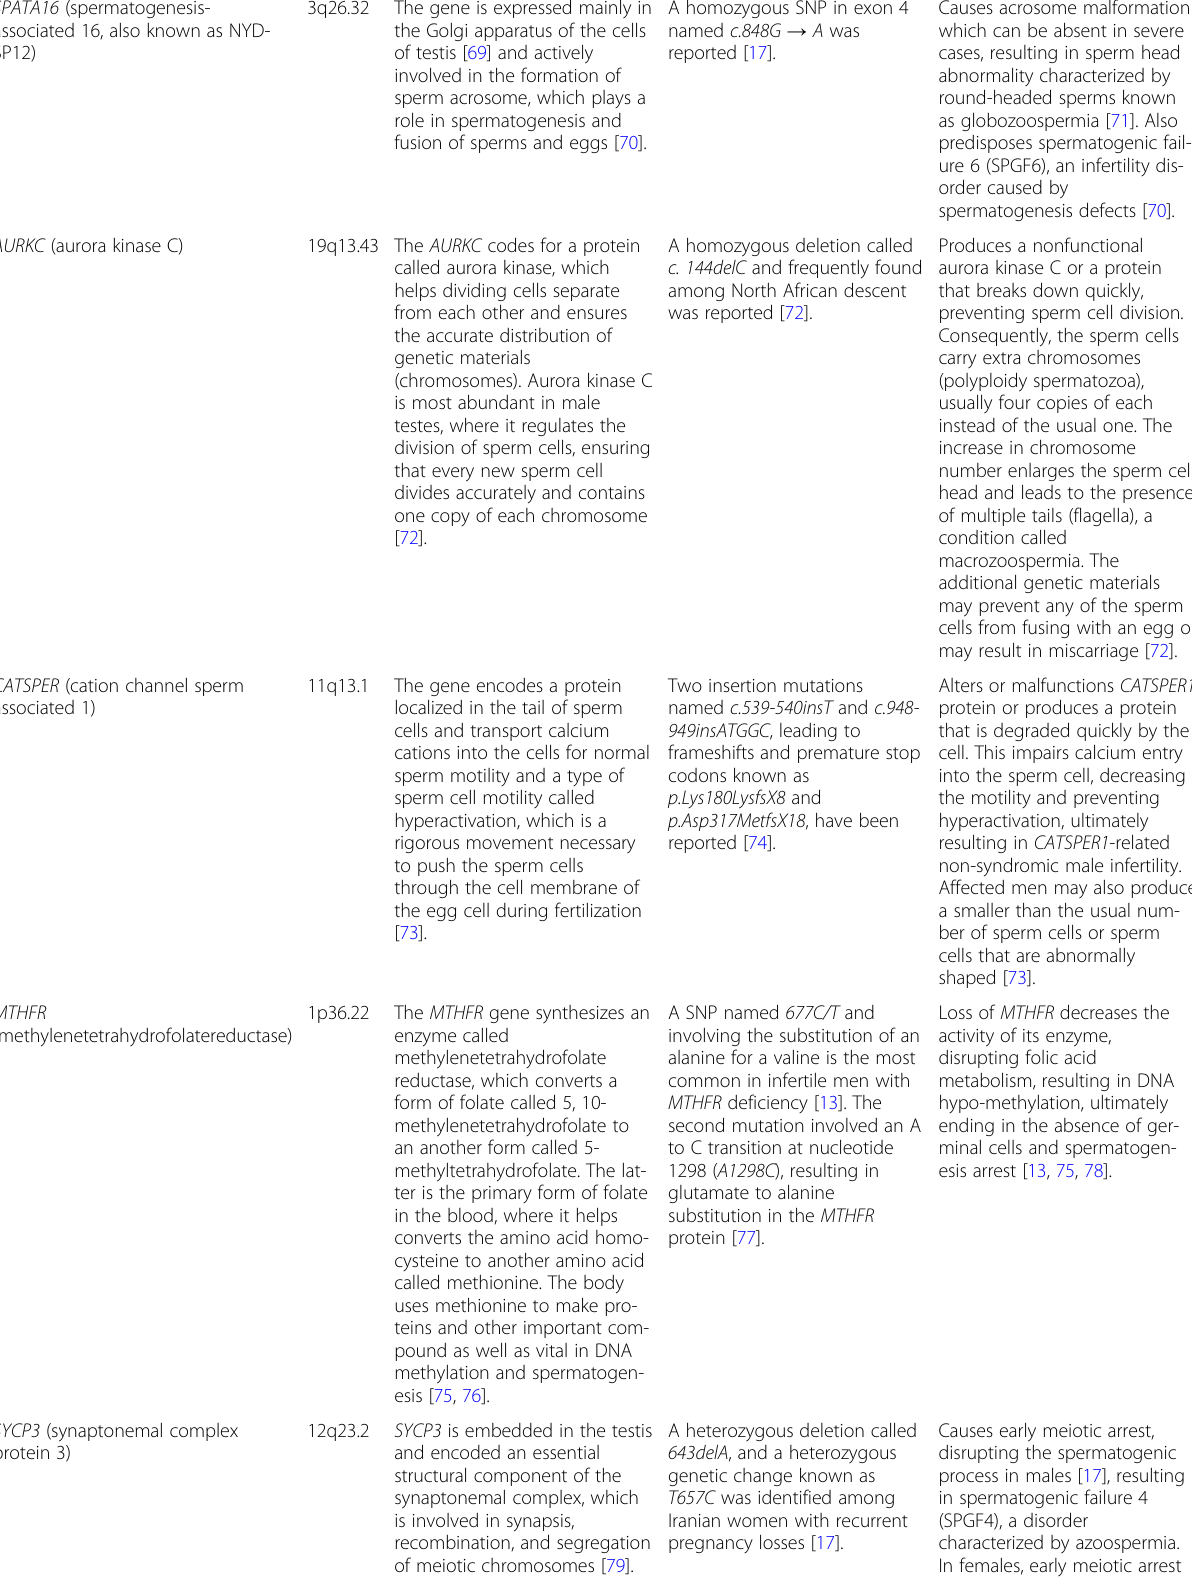
Table 2 Genes predisposing to nonsyndromic spermatogenic failure and sperm morphological abnormalities SPATA16 (spermatogenesis- associated 16, also known as NYD-